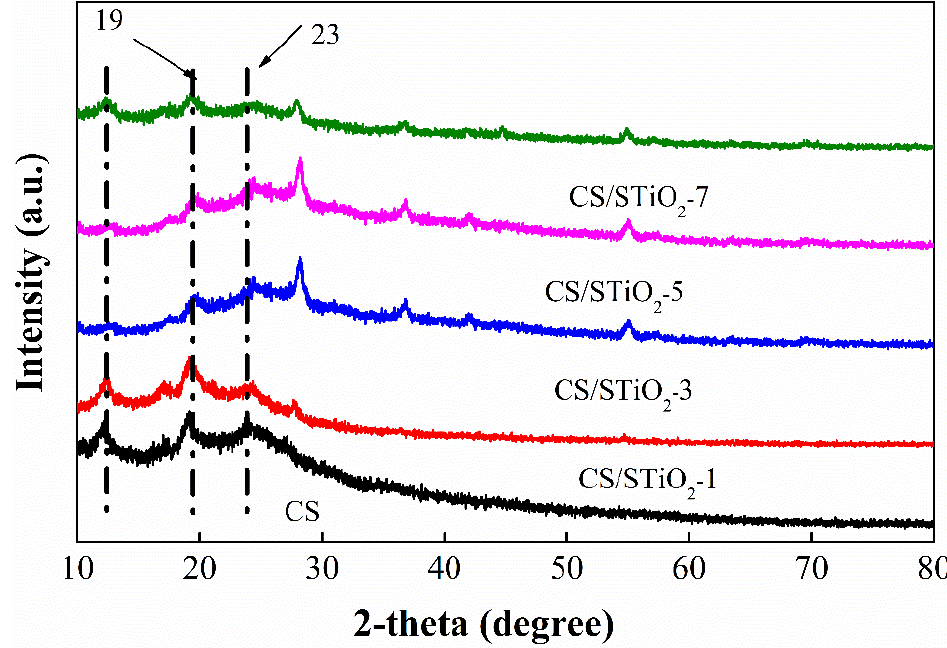
Figure 4. The XRD patterns of CS control and CS/STiO 2 nanocomposite membranes .